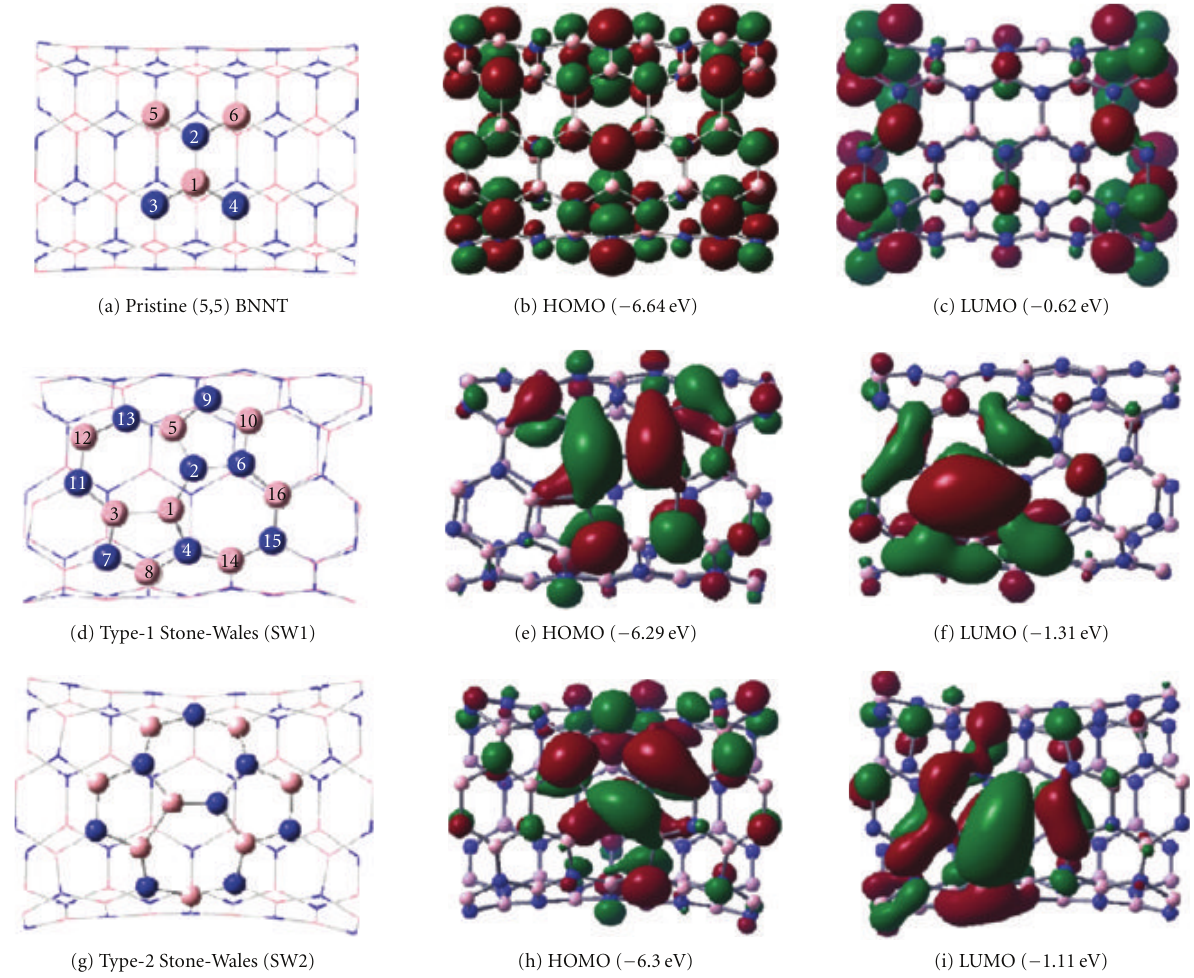
Figure 17: Optimized geometries of pristine, SW1-defective, and SW2-defective B 45 N 45 H 20 and their relevant FMOs. Orbital energies are in parentheses [200]. Legend: pink = boron, navy blue =